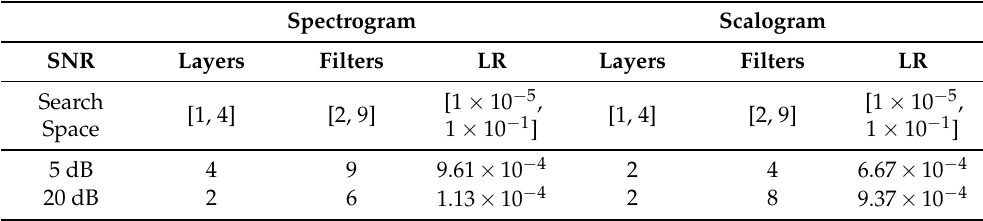
Table 6. Number of convolution layers and filters and the initial learning rates (LRs) for the CNN chosen through Bayesian optimization for classification of the material (aluminum, granite, stainless steel 347, or tungsten carbide). The hyperparameter search space is also